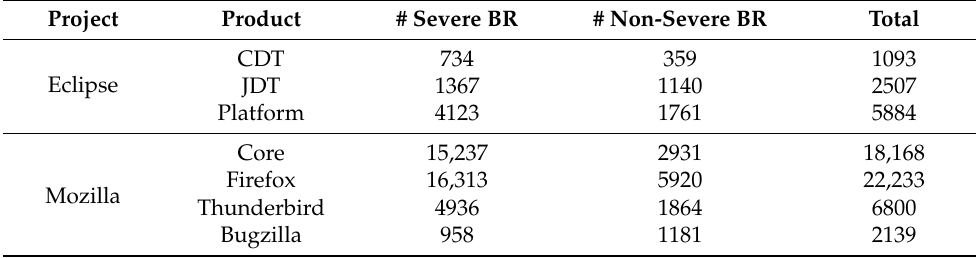
Table 3. Datasets for word vector training and severity